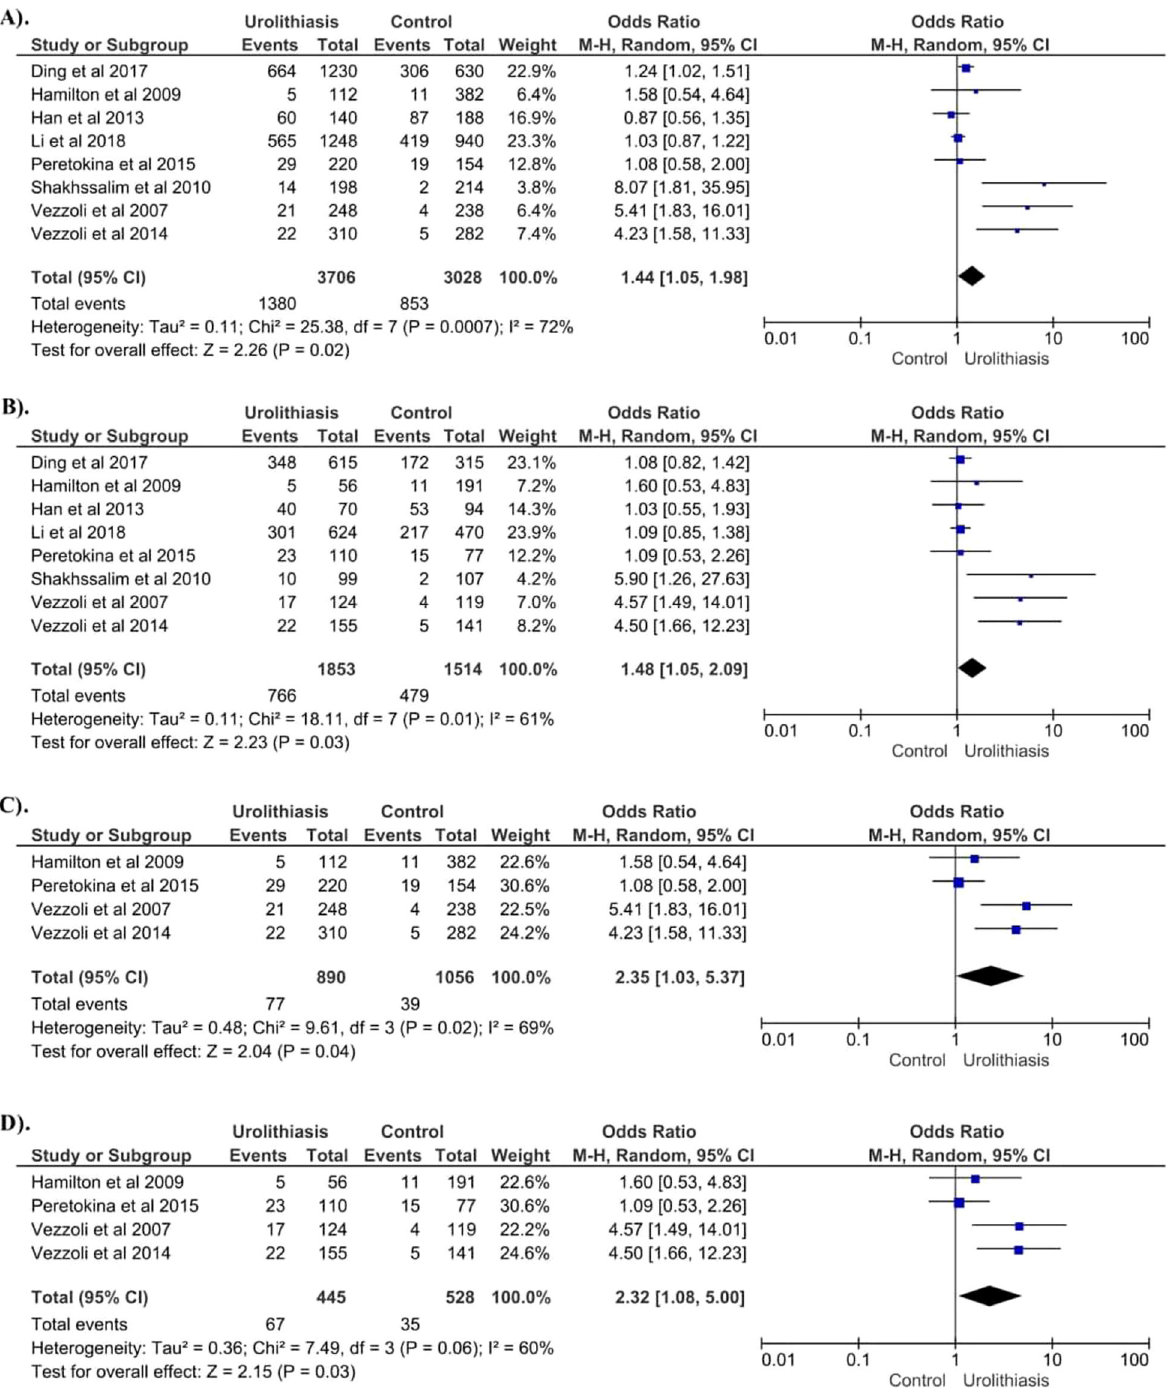
Fig. 2 Forest plot of the correlation between R990G gene polymorphism and the risk of urolithiasis. a (G vs. R) and b (RG vs. RR + GG) summarize overall correlation. On other hands, c (G vs. R) and d (RG vs. RR + GG) describe the correlation in Caucasian sub-group